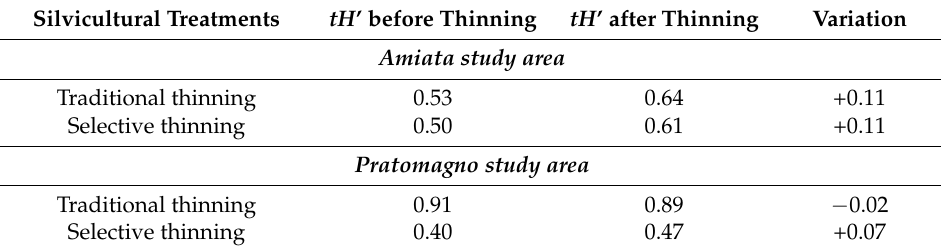
Table 4. Tree species’ Shannon index ( tH ’) before and after thinning in the two study areas. Silvicultural Treatments tH ’ before Thinning tH ’ after Thinning Variation